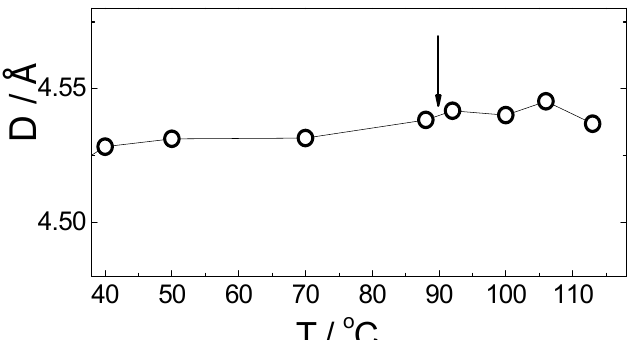
Figure 8. Temperature dependence of the average distance, D, between the long axis of the FLC molecules measured by WAXS on cooling for the PE-FLC nanocomposite. Vertical arrow indicates the SmA*-SmC* phase transition temperature.